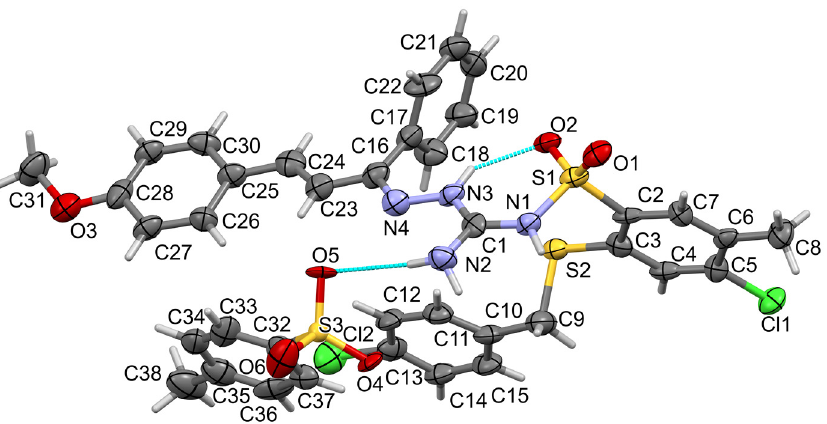
Figure 4. Molecular structure of 31 showing the atom labeling scheme and hydrogen bonding shown as cyan dashed lines. Second part of disordered -SO 3 - groups is omitted. Displacement ellipsoids are shown at 50% probability. Selected bond lengths (Å) and angles (°): S1-N1 1.655(12), S1-C2 1.771(14), C1-N1 1.339(19), C1-N2 1.338(19), N3-N4 1.392(19), C1=N3 1.29(2), N4-C16 1.32(2), C23-C24 1.32(2),